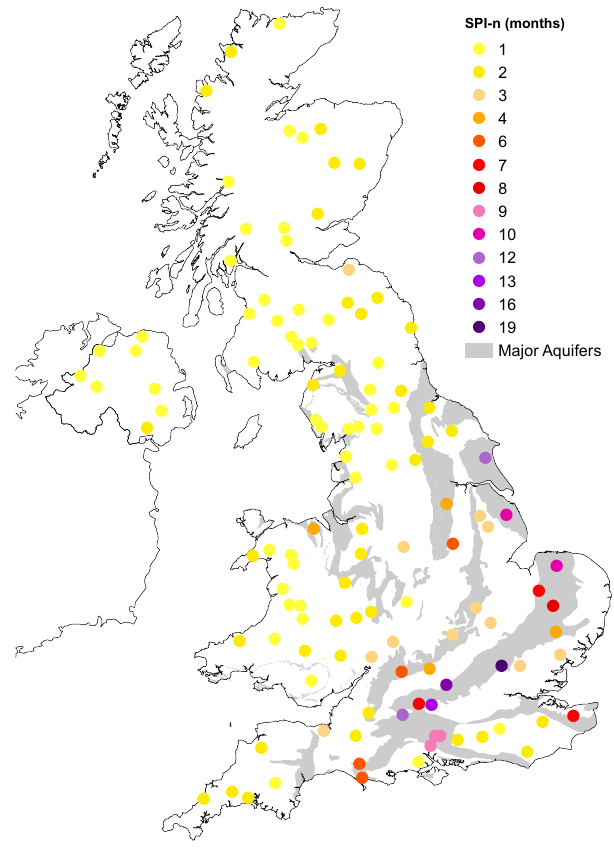
Figure 8. Map of catchments showing the SPI accumulation period most strongly correlated with SSI-1 (SPI- n ) and the location of ma- jor UK